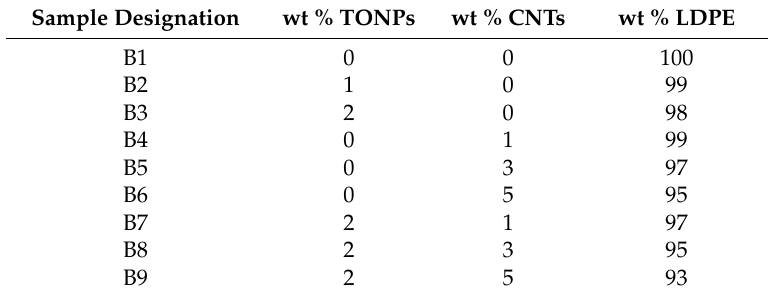
Figure 1. Illustrative diagram of mixing procedure. Table 1. Designation and formulation of the synthesized low-density polyethylene (LDPE)-based composite films. TONP—titanium oxide nanoparticle; CNT—carbon nanotube.